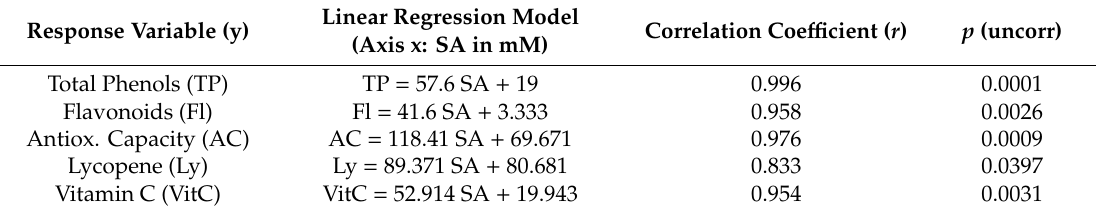
Table 4. Linear regression models (y = ax + b) and correlation coe ffi cients for five nutraceutical quality variables in response to SA foliar